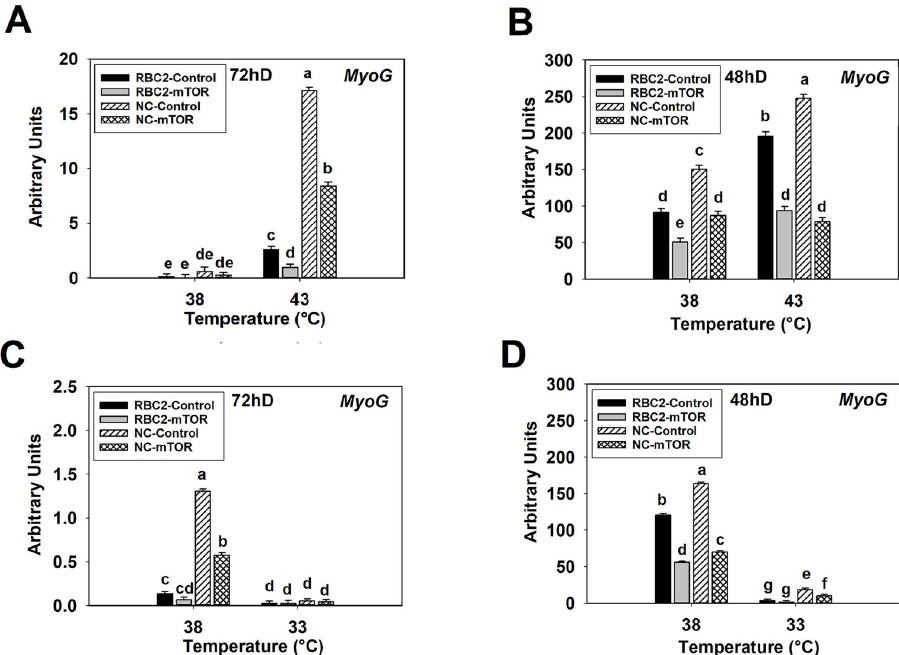
Fig 8. Effect of heat or cold thermal stress and siRNA-mediated knockdown of mTOR at the beginning of proliferation on the expression of MyoG in RBC2 and NC line SCs. After transfection with either a negative control siRNA (Control) or a siRNA targeting mTOR (mTOR), SCs proliferated at 38˚ or 43˚C for 72 h (A) followed by 48 h of differentiation (B). After transfection with either a negative control siRNA (Control) or a siRNA targeting mTOR (mTOR), SCs proliferated at 38˚ or 33˚C for 72 h (C) followed by 48 h of differentiation (D). Each graph bar represents a mean arbitrary unit, and each error bar represents a standard error of the mean. Mean values different letter are significantly different ( P �